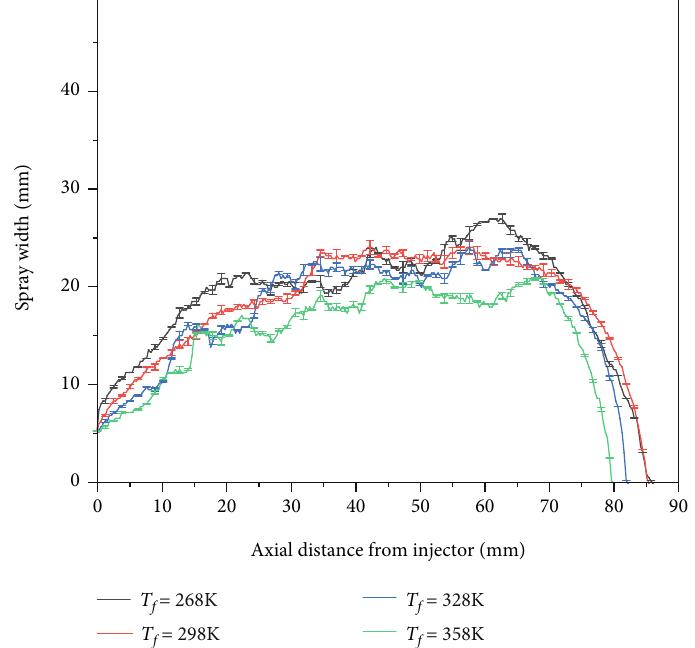
= 0 : 8 MPa , Δ T = 4 : 0ms f f